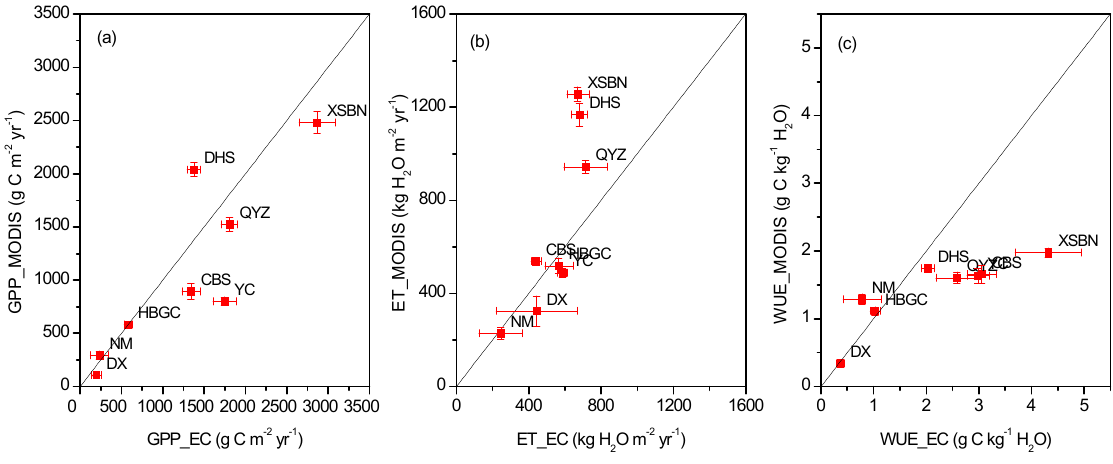
Figure 5. Comparison of MODIS- and eddy covariance-derived annual ( a ) Gross Primary Production (GPP), ( b ) Evapotranspiration (ET) and ( c ) Water Use Efficiency (WUE) at eight ChinaFLUX